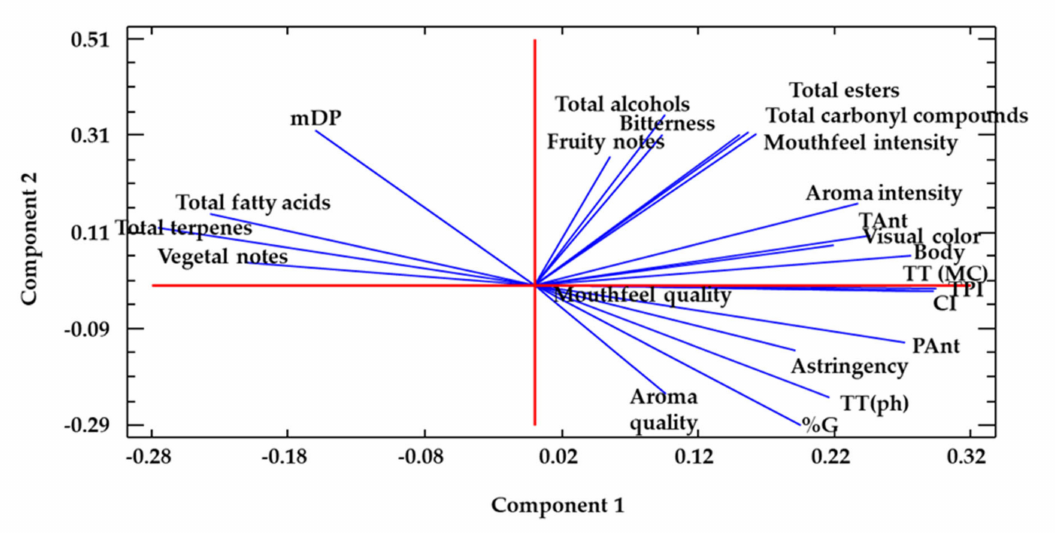
Figure 3. Distribution of the weight of the di ff erent variables used in the principal component analysis. CI: color intensity, TPI: total phenol index, TAnt: total anthocyanins, PolAnt: polymeric anthocyanins, TT (MC): total tannins determined by the methylcellulose method, TT(ph): total tannins determined